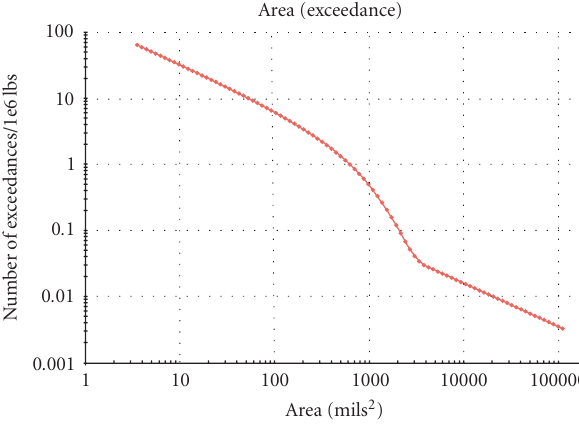
Figure 1: Exceedance curve: number of occurrence of anomalies versus crack size area per million pounds of